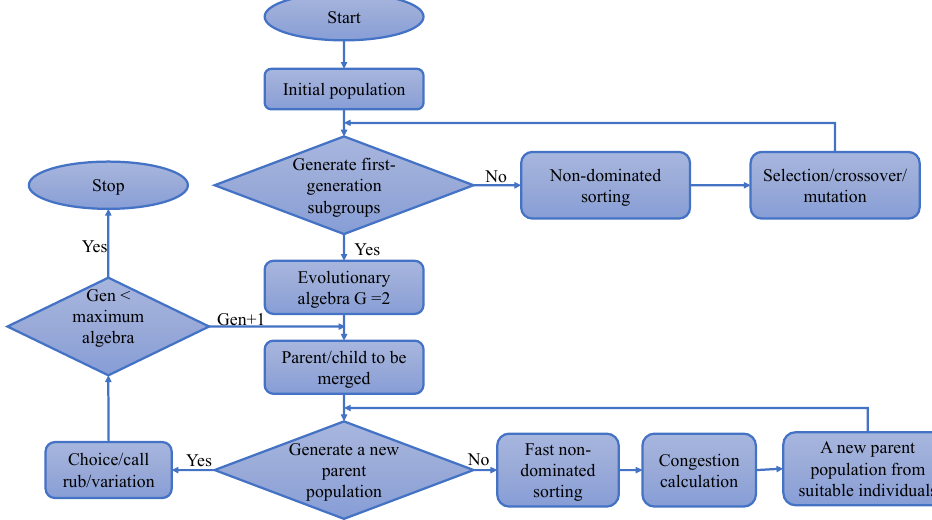
Figure 8. Flowchart of the NSGA- III.